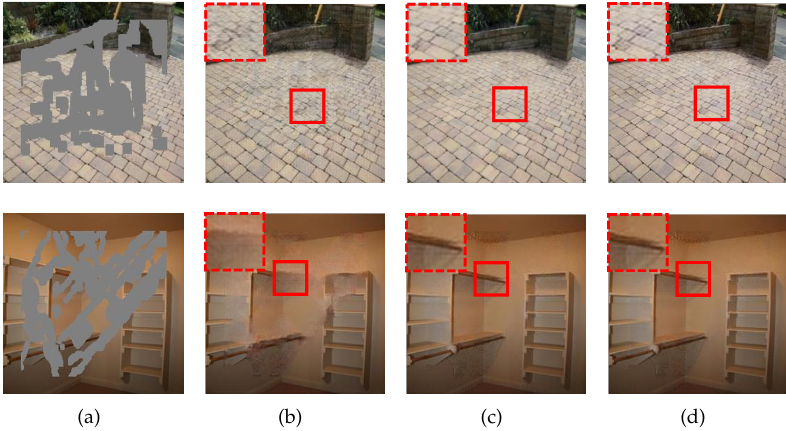
Figure 5. Qualitative results for the ablation study on the MSCA module. ( a ) Input images. ( b ) Re- sulting images for the setting n = ∅ . ( c ) Resulting images for the setting n = { 4,5 } . ( d ) Resulting images for the setting n = { 3,4 }